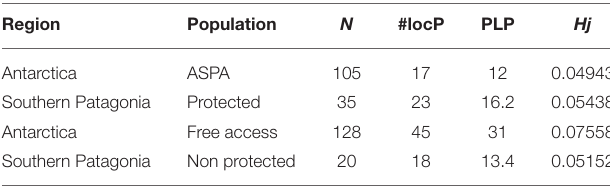
TABLE 1 | Results of regional genetic diversity among Antarctic Specially Protected Area (ASPA) and free access populations.